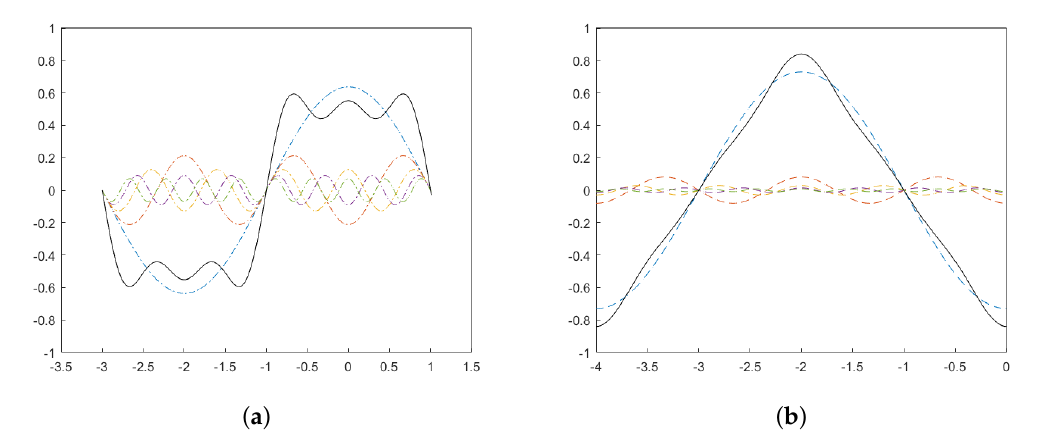
Figure 1. Fourier series and the sum of four first terms. ( a ) a square waveform; ( b ) a triangle